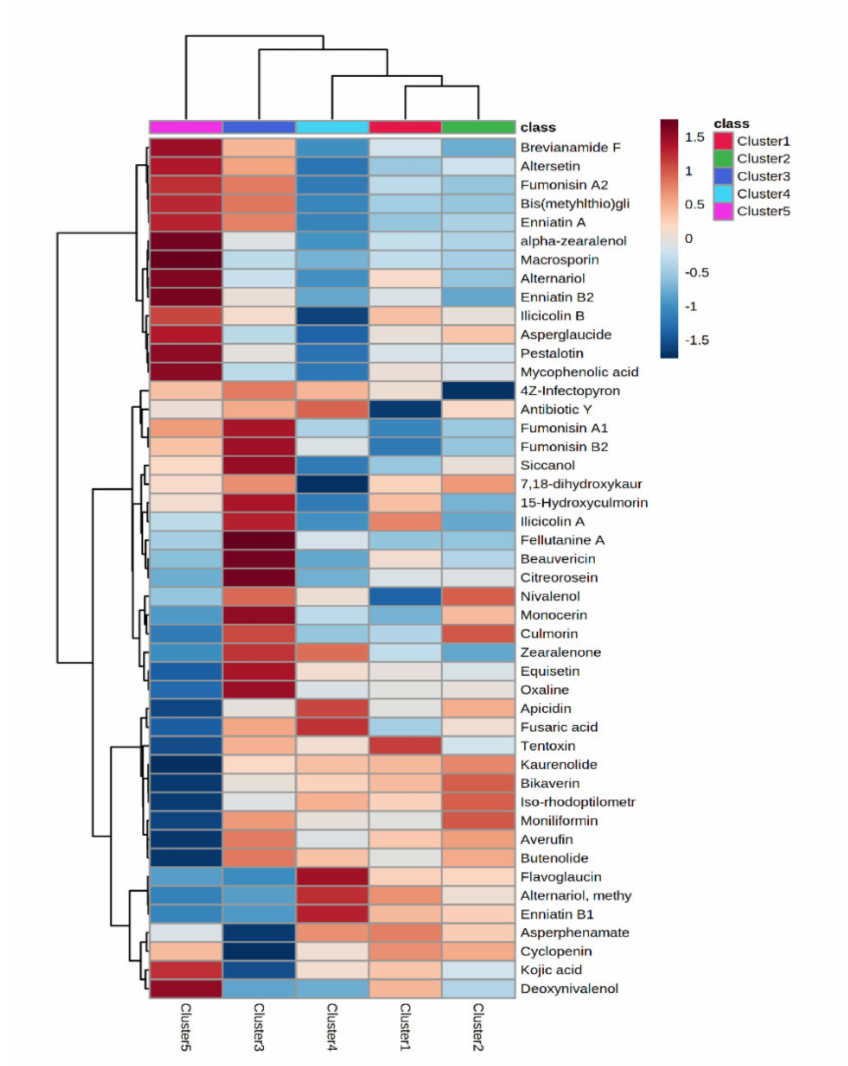
Figure 2. Heat map showing the average clustering (distance measure: Euclidean; clustering al- gorithm: Ward) of the milk samples according to the mycotoxins detected. The log2 fold-change (FC) values of each abundance were used for the cluster analysis with the Mass Profiler Professional software. Red and blue colors in each column indicate relative up- or down-accumulation of the mycotoxins,